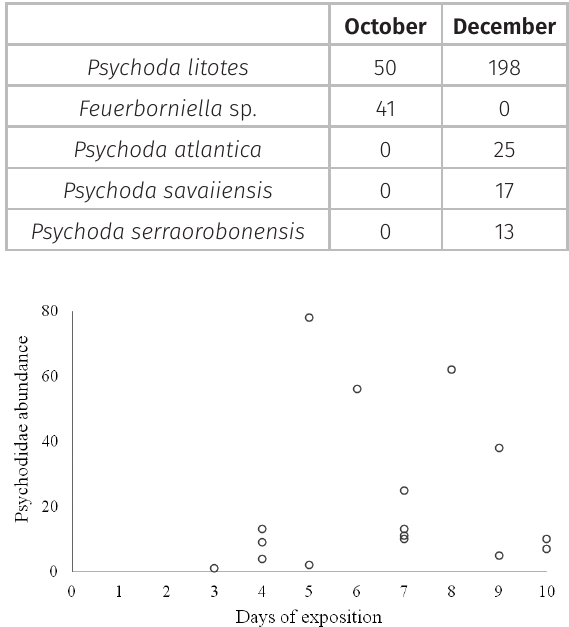
Figure 2. Total abundance of Psychodidae adults collected during October and December 2016 on 60 oviposition traps in relation to the fecal decomposition period (days of